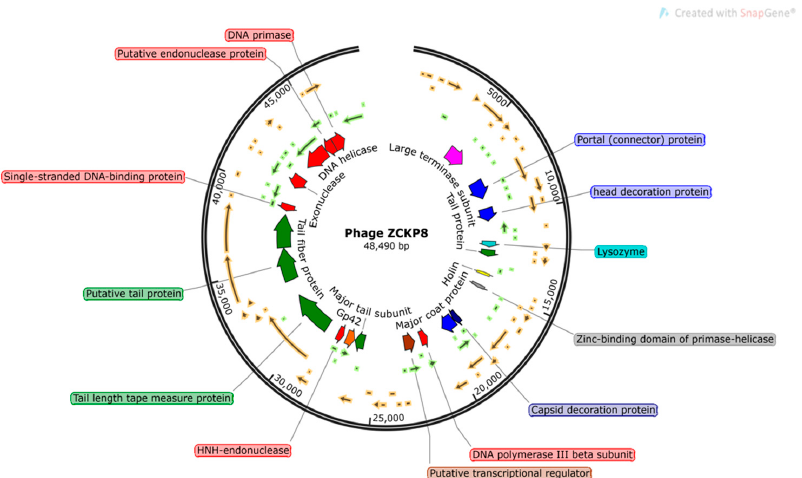
Figure 2. Phylogenetic relationships between ZCKP8 phage and BLASTN top-matched phages. The closely related phage is Klebsiella phage ZX4 (GenBank Acc. No. NC 054654.1).